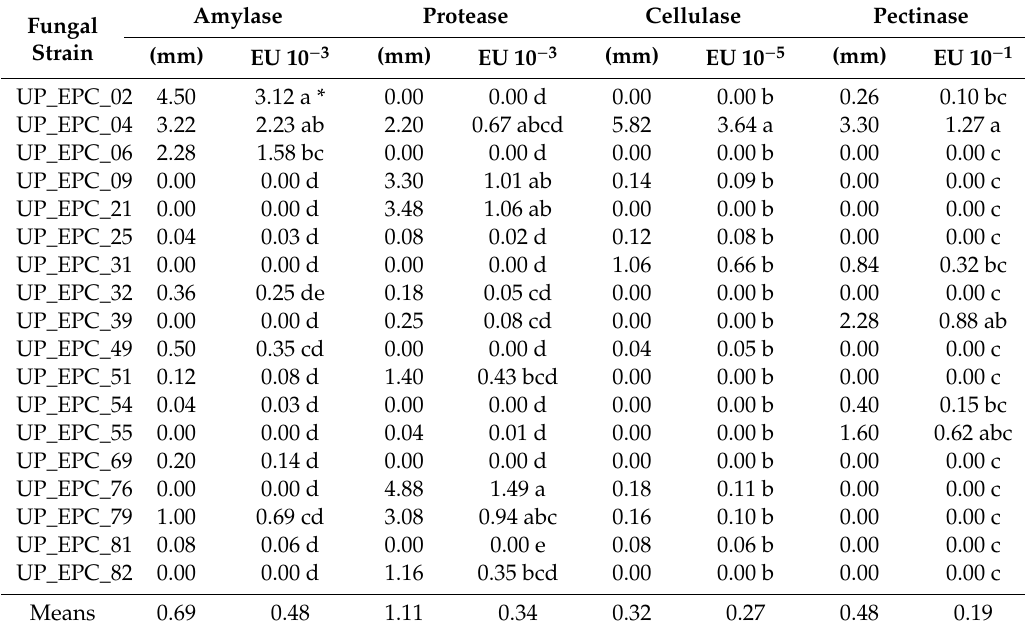
Table A3. The size of the discoloration of the zones around the holes (mm) and number of enzymatic units (EU) synthesized by 18 strains of E. nigrum in 1 mL of medium. Fungal